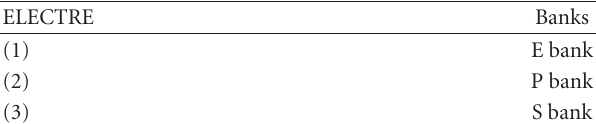
Table 10: Summary ranking by